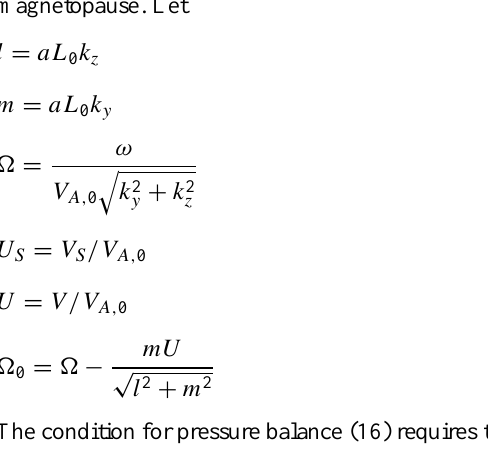
Fig. 2. Amplitude and phase of the reflection and transmission coefficients when excitation of the resonance is neg- ligible. ρ 0 , 2 = 0 . 1 ρ 0 , 1 , k z = 3 /aL 0 , k y = 3 /aL 0 , V/V A, 0 = 0 .